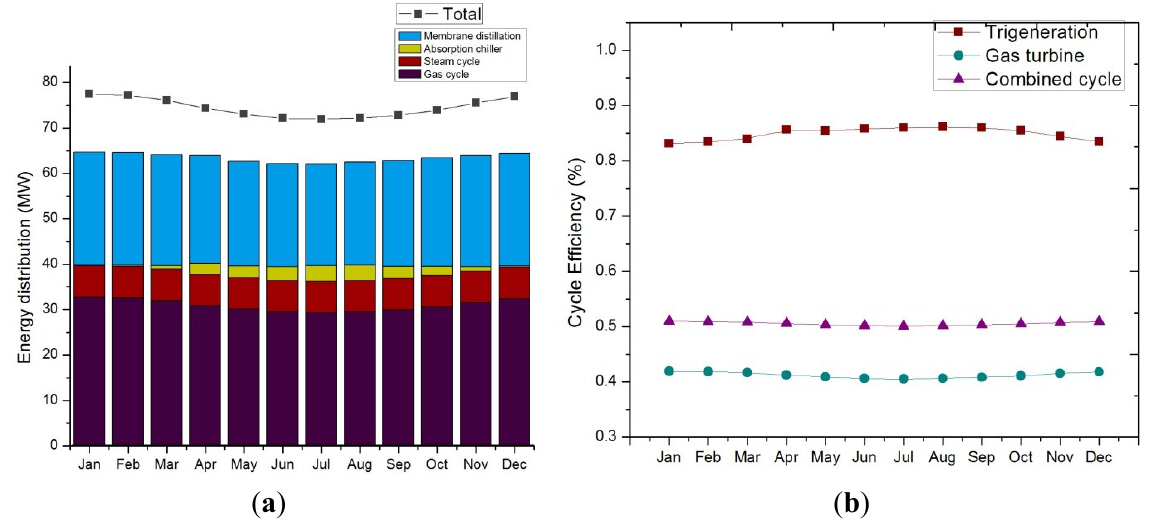
Figure 14. ( a ) Month-wise energy distribution; ( b ) Annual distribution of cycle